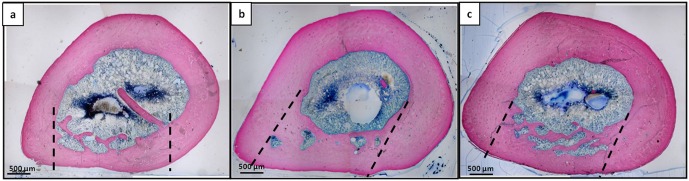
Histological microphotographs of entire transversal femoral sections passing through the lesion at 90 days after implantation.a) Unfilled defect; b) Pluronic F127 filled defects; c) DBM-PF127 composite filled defects. Sections were stained with Stevenel’s/Van Gieson stain. Dashed line indicate the defect edges.